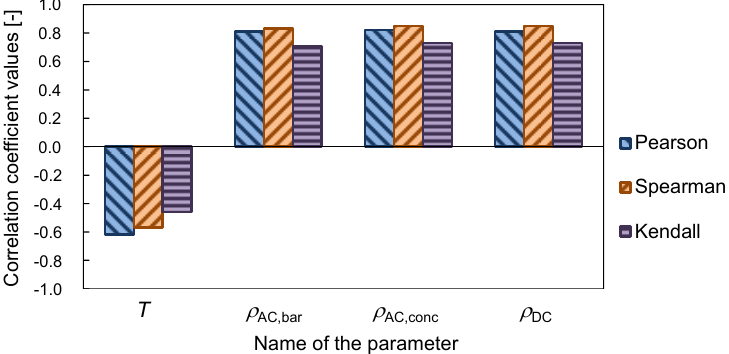
Figure 4. Pearson’s ( p ), Spearmann’s ( ρ s ), and Kendall’s ( τ ) rank correlation coefficient values between input parameters and the i corr .